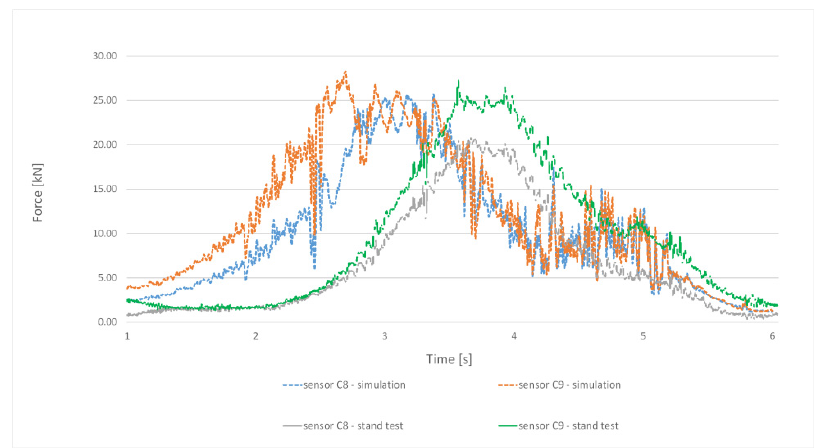
Figure 9. Force values in the vertical suspensions at travel speed 5 m/s. Forces in the diagonal suspensions at travel speed 5 m/s are presented in Figure 10.